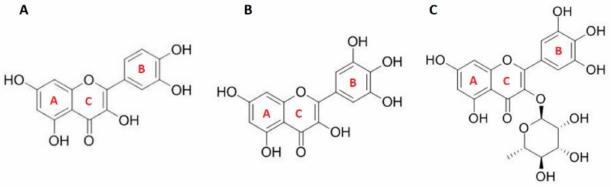
Figure 1. Structure of flavonols: ( A ) quercetin (QUE); ( B ) myricetin (MCE); ( C ) myricitrin